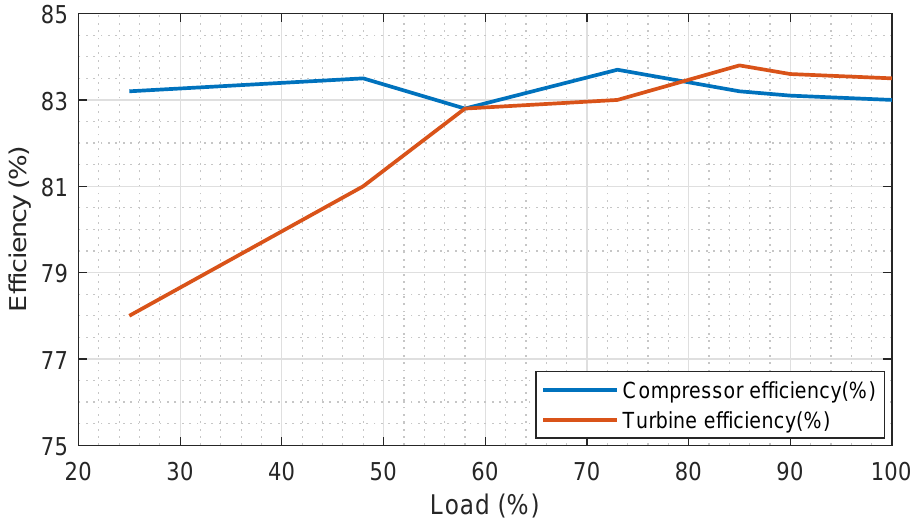
Figure 5. Efficiency of a turbine and compressor as function of load [2].